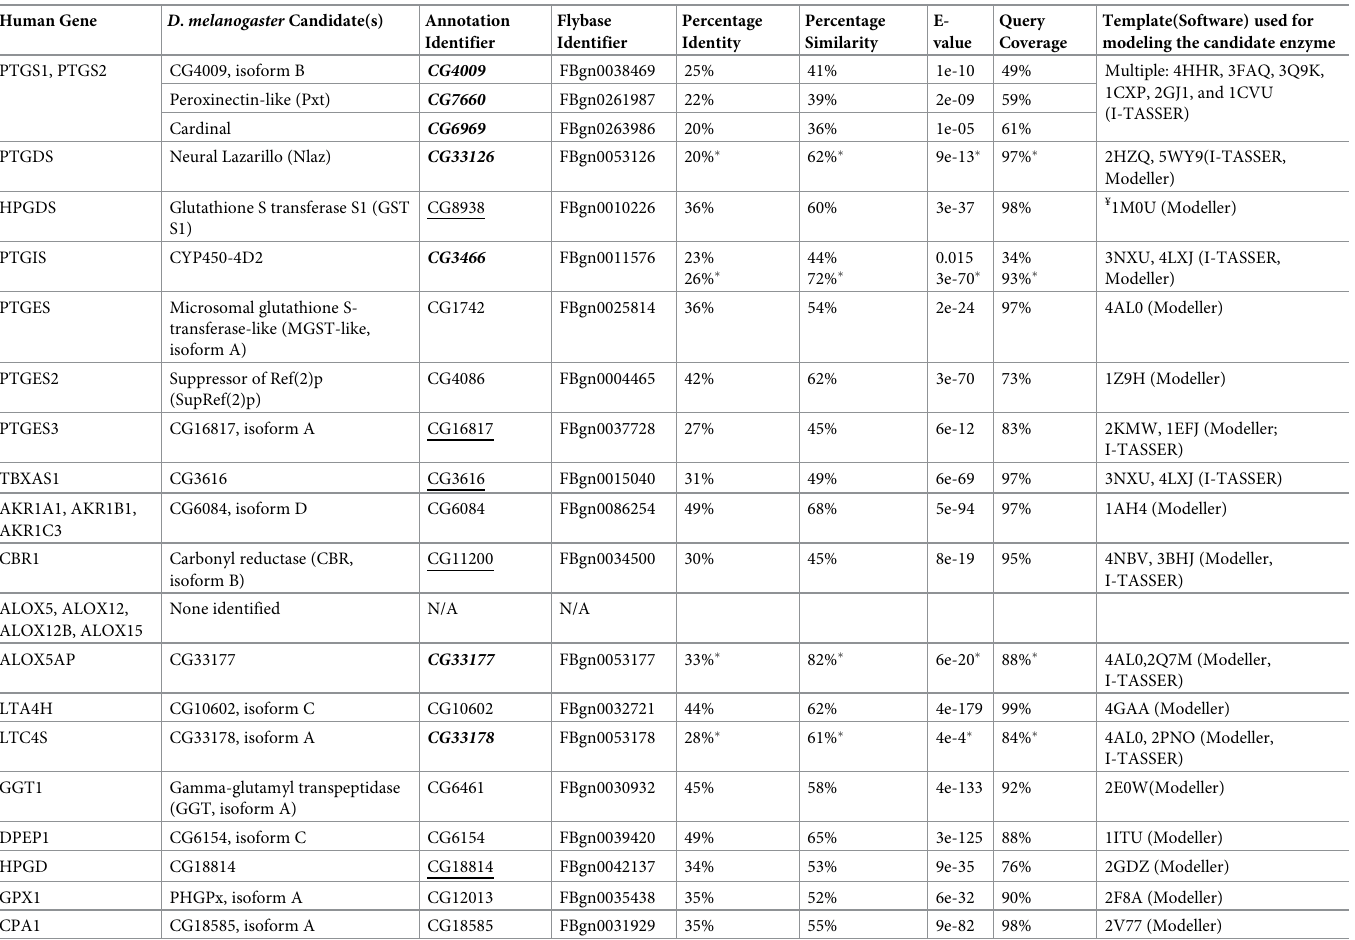
Table 1. Summary of D . melanogaster eicosanoid synthesis enzymes candidates. Human